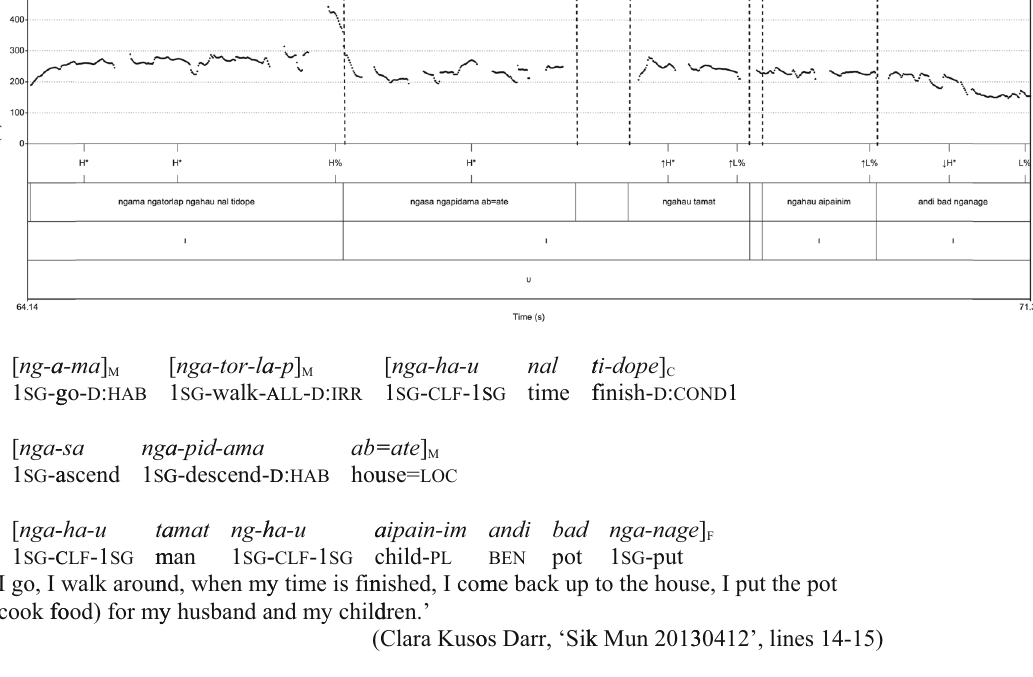
Figure 7: Clause chain with medials lacking boundary